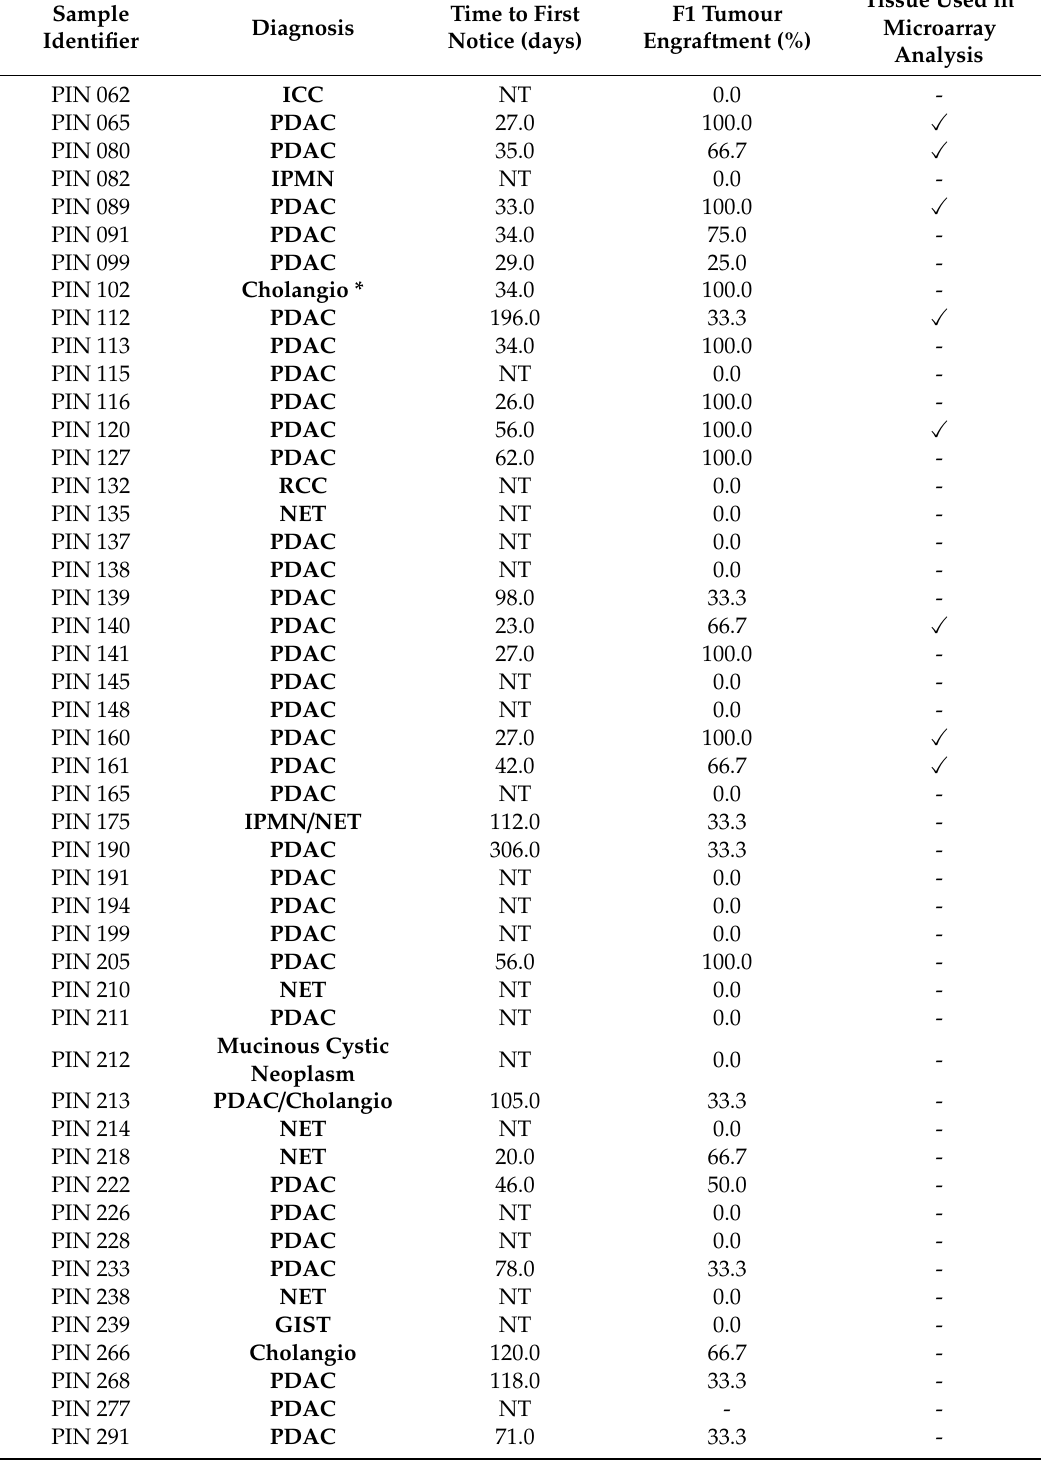
Table 3. Tumour diagnosis, take rate and growth in first generation in